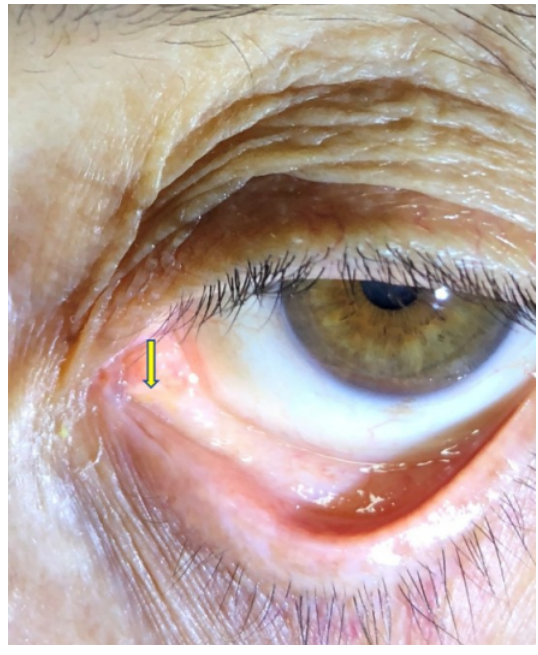
Figure 1: Canalicular laceration (arrow) after silicone tube extraction